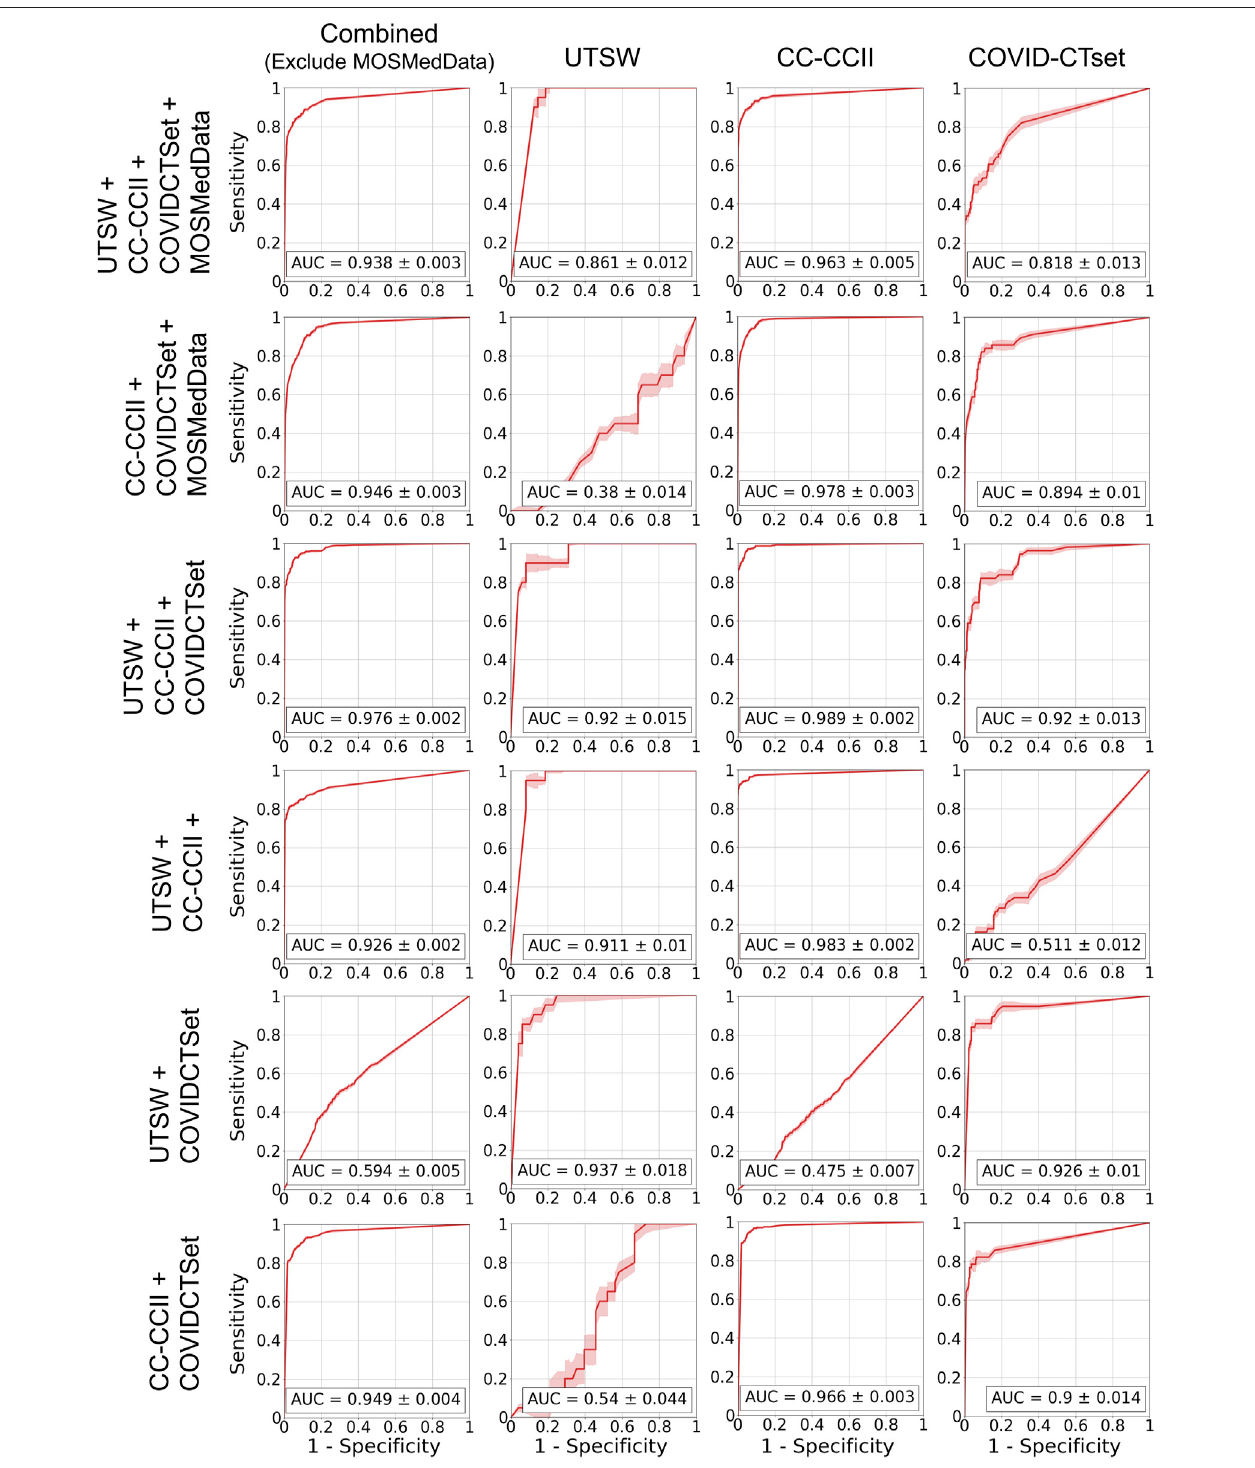
FIGURE 6 | ROC curves on the test data for the models that trained on multiple datasets. Each row represents the datasets that the model was trained on, and each column represents the datasets that the model was evaluated on. The error band and the error value in the reported AUC represent 1 standard deviation.